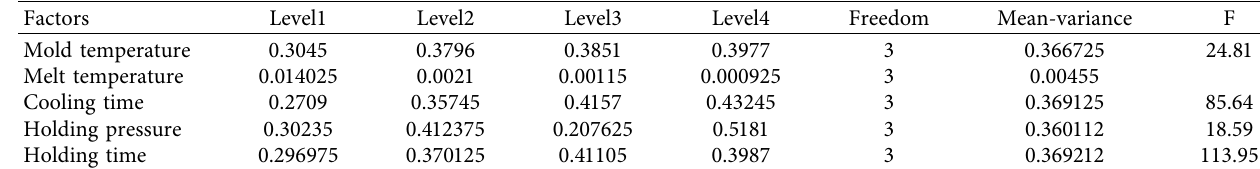
Table 6: Analysis of variance of volume